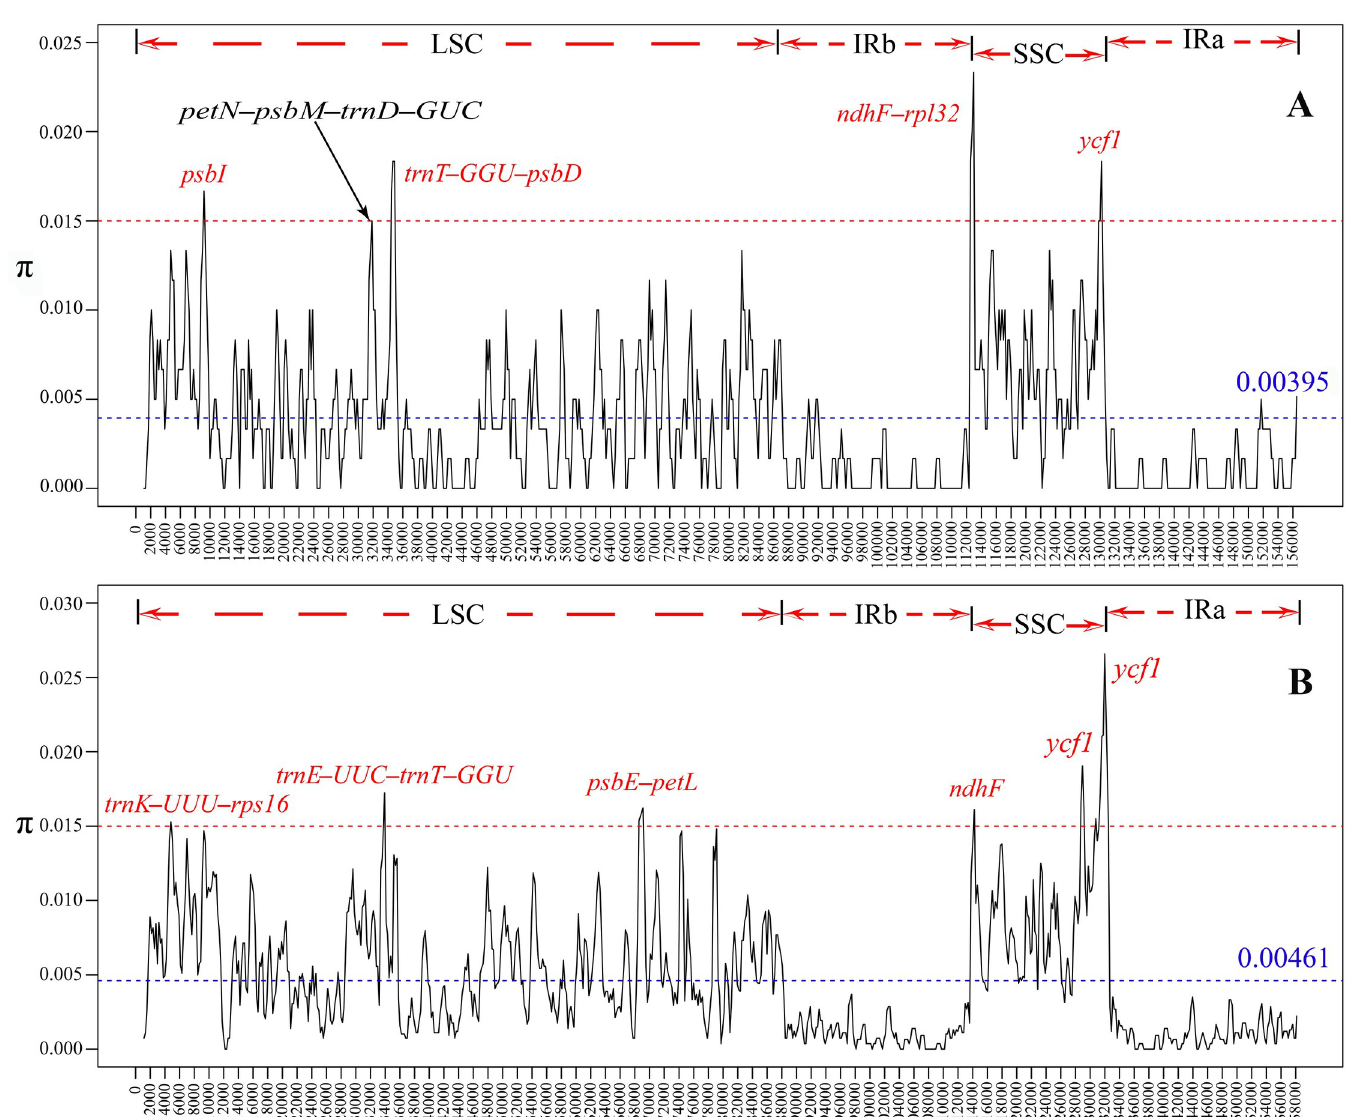
Fig 5. Comparison of the nucleotide variability ( π ) values of the two Brassaiopsis plastomes (A) and nine plastomes of the Asian Palmate group (B). (Window length, 600 bp, step size, 200 bp); x-axis: position of the midpoint of a window; y-axis: nucleotide diversity of each window.